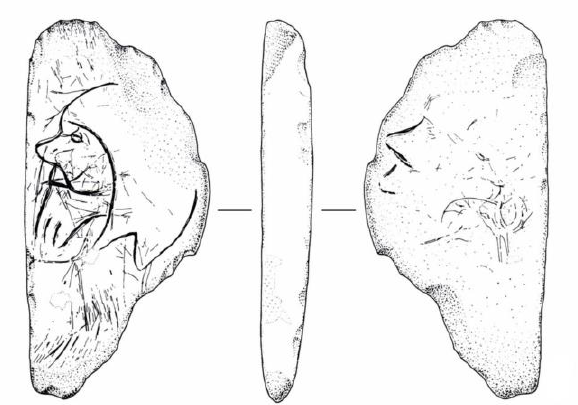
Figure 2: Drawings of the limestone slab (after Martini